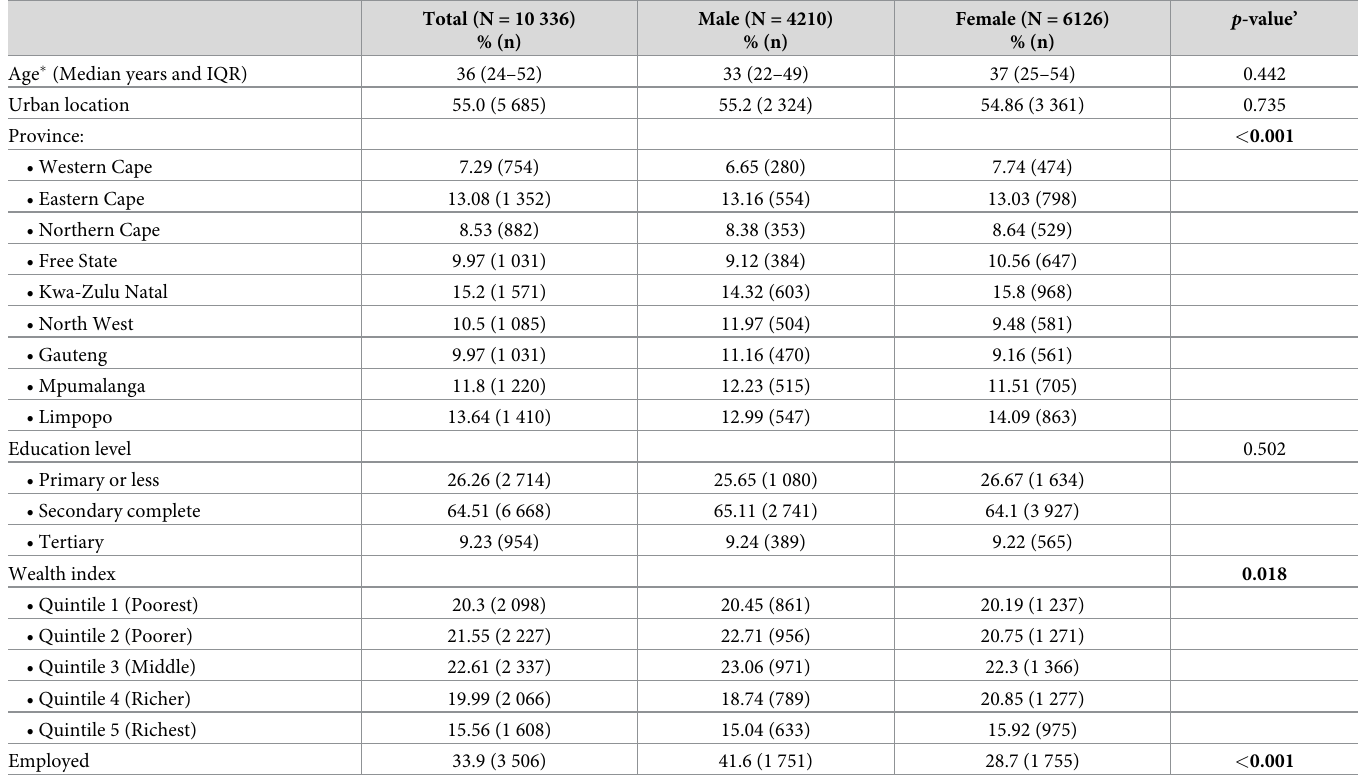
Table 2. Description of sample population